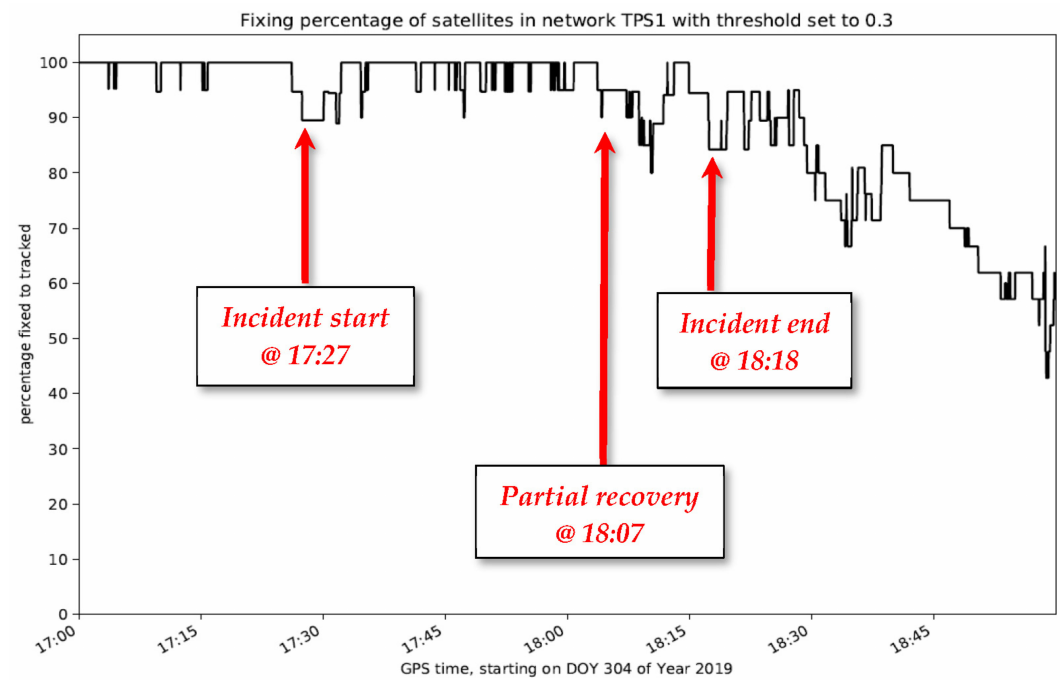
Figure 18. Fixing rate of the TAPAS network during the incident in Case 2. This shows the percentage of available satellites that are integer fixed in the